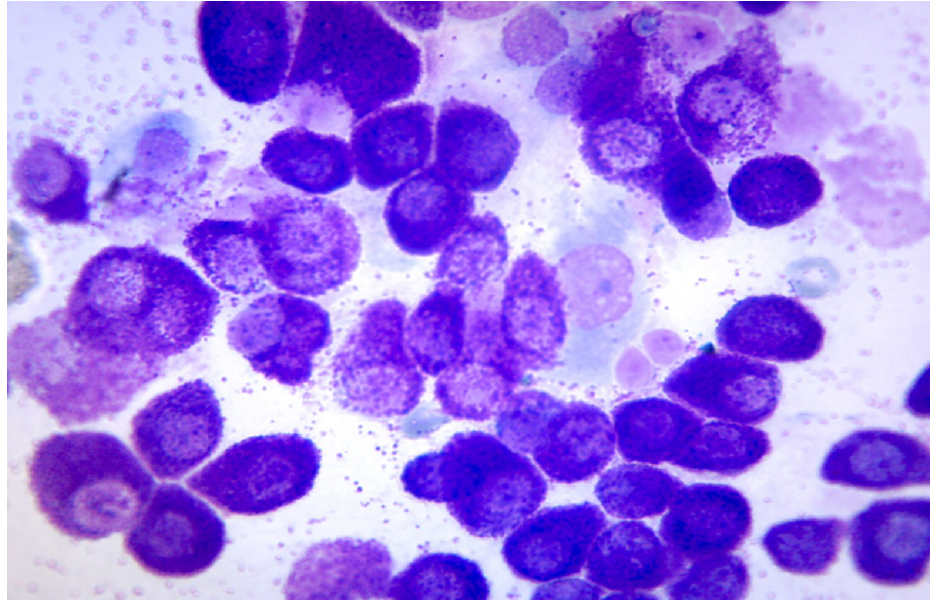
Fig. 2. Cytogram of mastocytoma with a low degree of malignancy. Clusters of cells of homogeneous structure. Mixed-grained mast cells (most cells are highly granular and fewer less granular) with minimal anisocariasis; According to Romanovsky- Gimza. EP. 10, lens 100